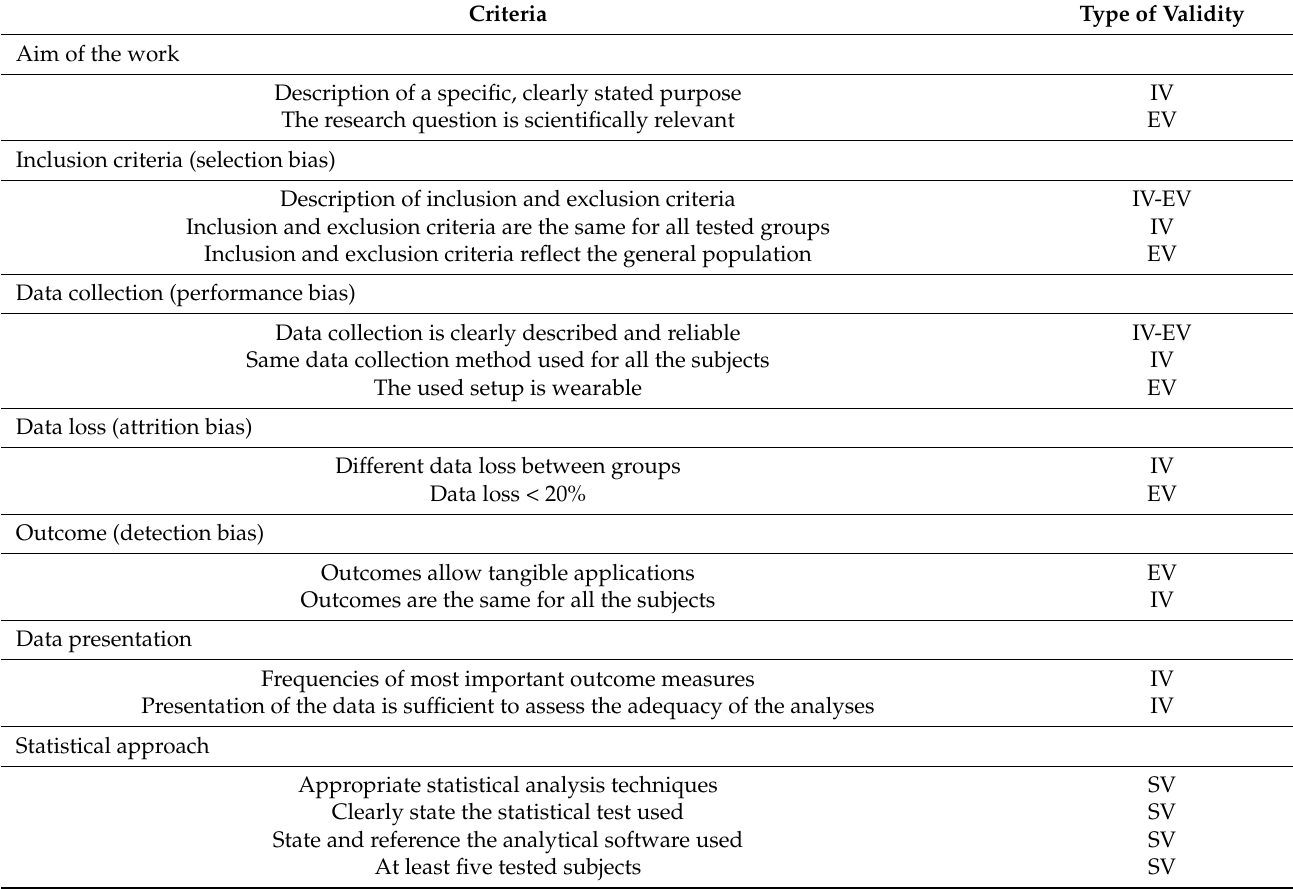
Table 1. Quality assessment for internal (IV), external (EV) and statistical (SV) validity. Criteria Type of